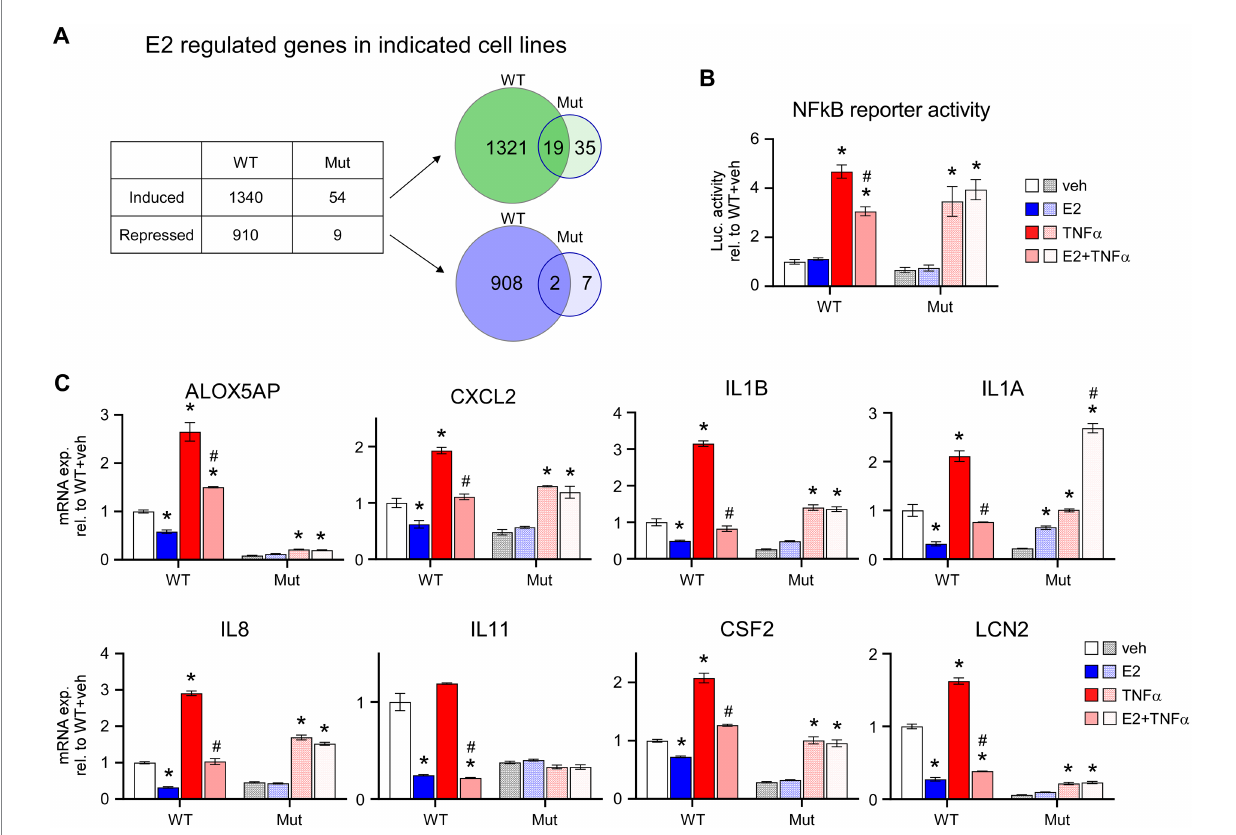
FIGURE 3 E2-mediated transcriptional activity of ER β DBD-Mut . (A) Number of genes induced or repressed by WT ER β or ER β DBD-Mut (Mut) following 5 days of E2 treatment as identified via RNAseq. Venn diagrams show overlap of genes induced (upper) and repressed (lower) by WT and Mut ER β . (B) Activity of a NF κ B luciferase reporter construct in WT and Mut ER β expressing MDA-MB-231 cells following dox exposure and indicated treatments. (C) Expression of NF κ B target genes in dox-induced WT and Mut MDA-MB-231-ER β cells following indicated treatments. All data is normalized to WT ER β + veh treated cells. * Indicates p < 0.05 relative to veh treatment and # indicates p < 0.05 relative to TNF α treatment for each cell line